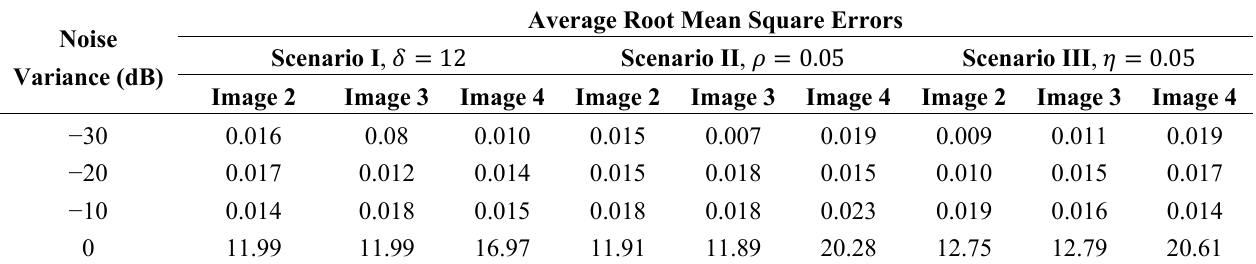
Table 7. The residual registration errors for various noise variances and β (cid:3404) 0. Noise